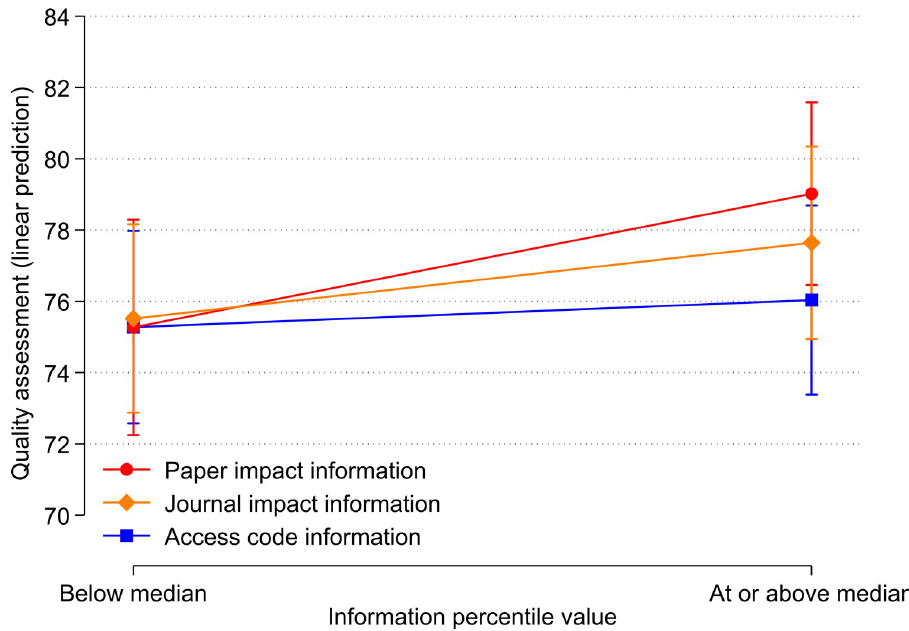
Fig 1. Relationship between treatments (access code, journal impact, and paper impact information) and quality assessment by respondents.